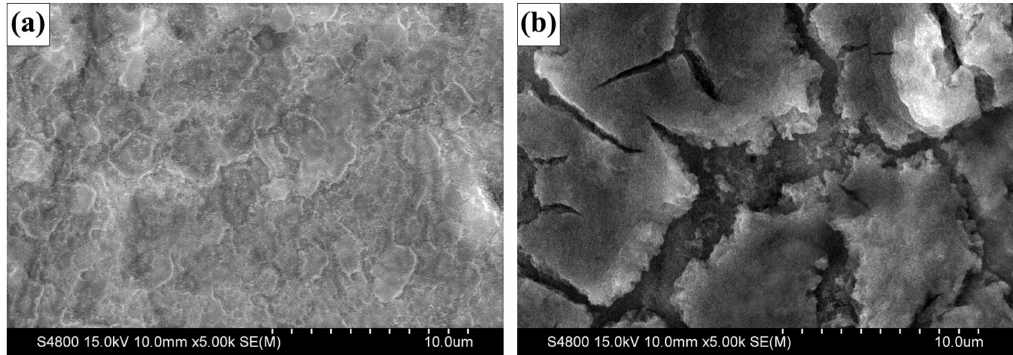
Figure 7. SEM images of ( a ) ZnO / Ni and ( b ) ZnO electrodes after 20